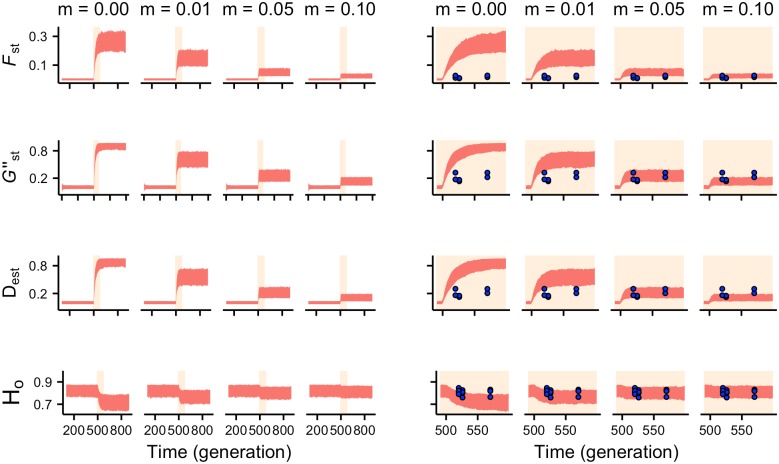
Values of FST, G”ST, DEST and Ho through time (generations) estimated from computer simulations for different migration rates after a ‘highway’ replaces at generation 500 a previous scenario of panmixia and assuming a multigeneration Ne of 54 for each roadside site.For each migration rate (m), the plots in the left panel show the evolution of the parameters through the simulation and the plots in the right panel show a detail of the simulations for the period in which the ‘highway’ has been introduced (apricot areas in the left plots). The 5–95 percentile envelopes (999 replicates for each migration rate value) are shown in light coral. In the right plots, the blue circles represent observed values, which are placed to the right of generation 500 according to the highway’s age and assuming a generation time of six months [88].